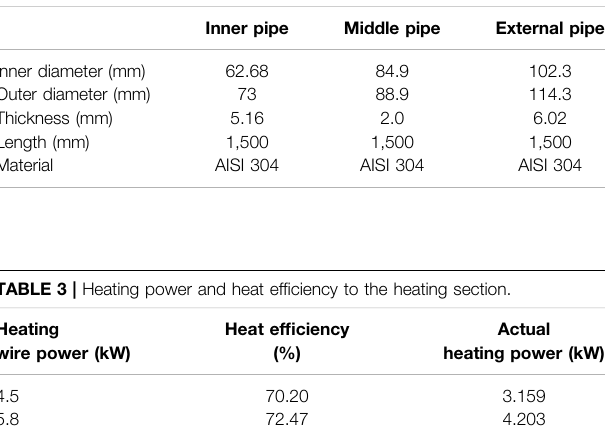
TABLE 2 | NACIE HX pipes ’